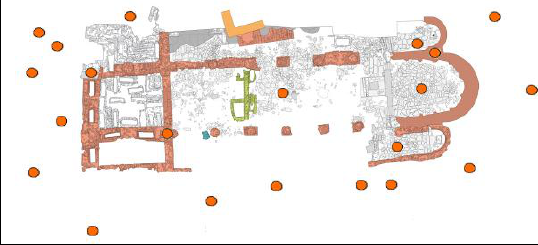
Fig. 5. Scan positions for the laser survey.